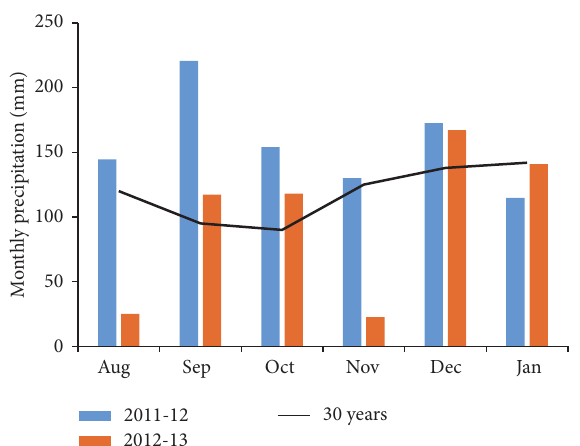
Figure 1: Monthly precipitation and 30-year mean values at Reedsville, WV.